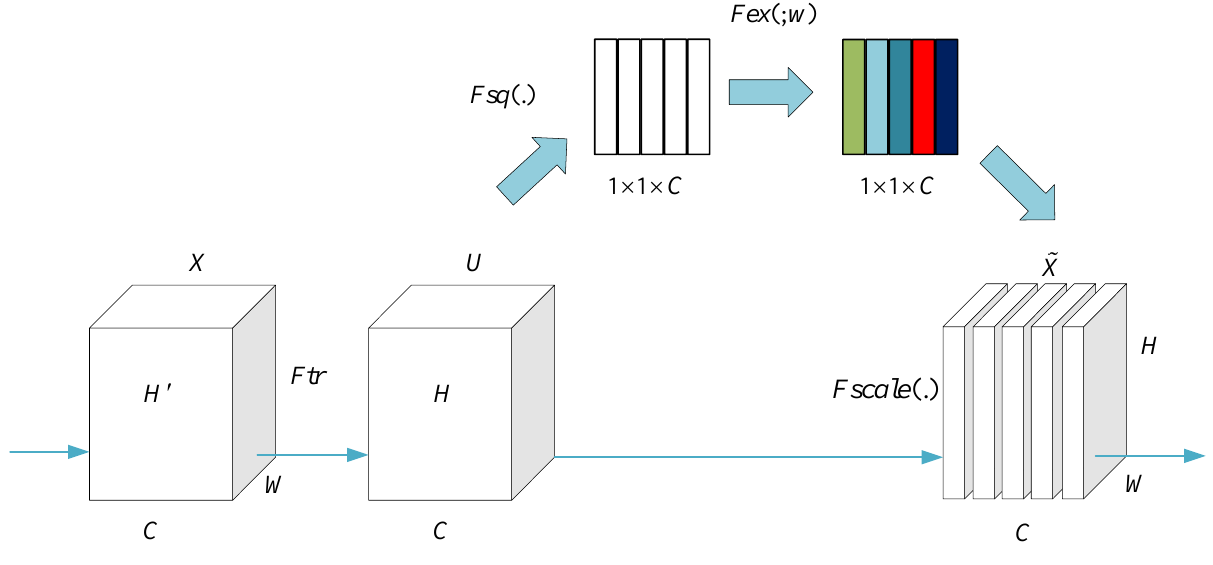
Figure A3. Schematic diagram of SE module construction.